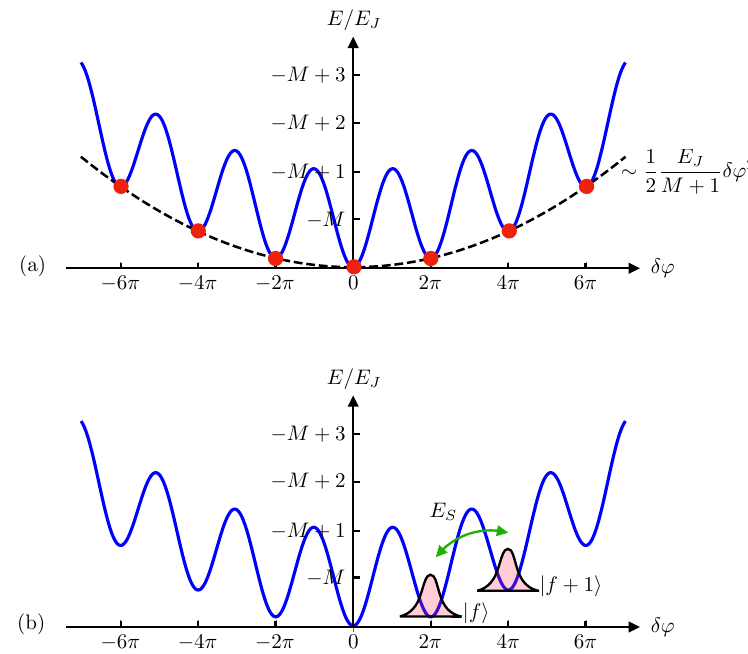
Figure 3: Sketch of the potential energy landscape, i.e., the Josephson energy = ϕ ( f ) + m δϕ for as defined in Eq. (9), as a function of δϕ , where ϕ m m M + 1 = 0. The deviation δϕ is chosen such that for δϕ be- m = 1,..., M , and ϕ 0, M + 1 ing multiple integers of 2 π , we pass through other minima, that is, for instance ϕ ( f ) + m ( δϕ + 2 π ) = ϕ ( f + 1 ) + m δϕ . In the plot here, we chose for simplic- m m M + 1 M + 1 ity ϕ = 0, and M = 105. In (a) the local minima are denoted as red dots. The energies at the local minima are given by a parabola with respect to δϕ (dashed / ( M + 1 )] − 1 . In (b) the local wave functions black line), with the focal length [ 2 E J | f 〉 , centered around the local minima are depicted. Quantum phase slips, occurring with energy scale E , are tunneling events between different local wave S